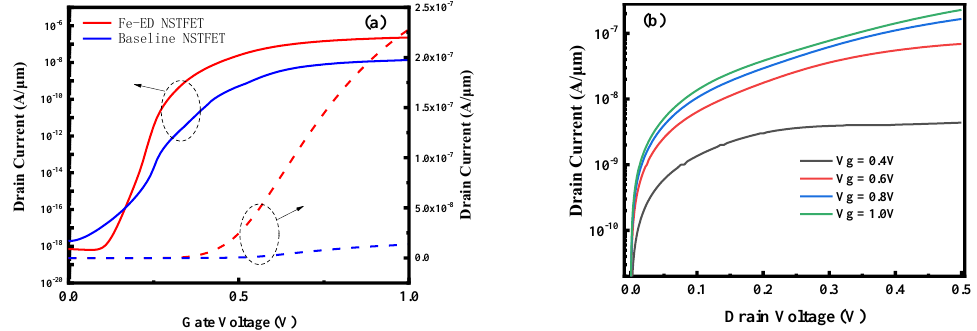
Figure 6. ( a ) I D – V G curves of Fe-ED NSTFETs and baseline devices. ( b ) I D – V D curves of Fe-ED Figure 6. ( a ) ID–VG curves of Fe-ED NSTFETs and baseline devices. ( b ) ID–VD curves of NSTFETs. Fe-ED